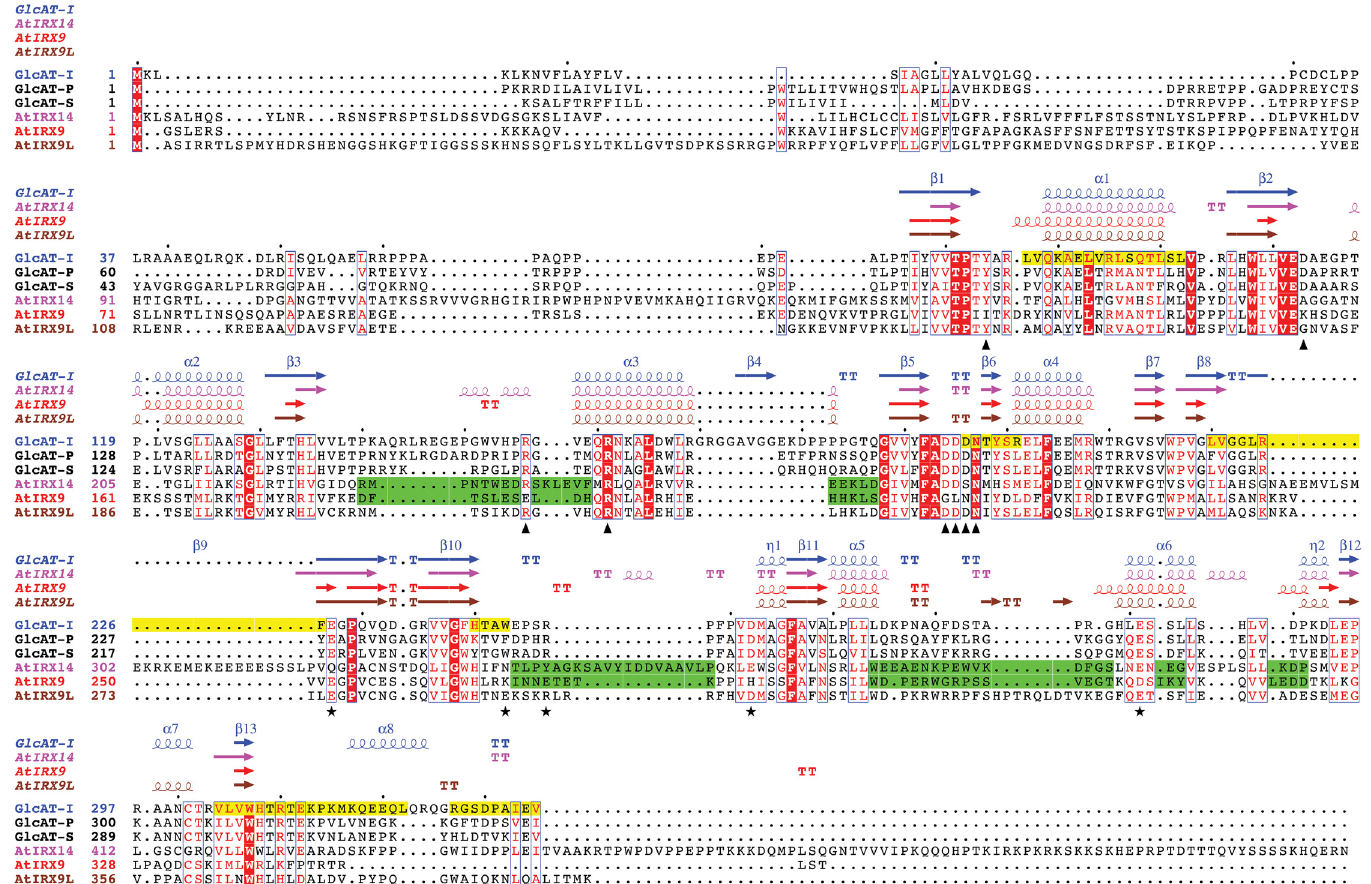
Fig 1. Sequence alignment of human and Arabidopsis GT43 proteins. Human proteins GlcAT-I (UniProt ID: O94766), GlcAT-P (Q9P2W7), GlcAT-S (Q9NPZ5) and Arabidopsis proteins AtIRX9, AtIRX9L and AtIRX14 were used to build the alignment using MAFFT program [41]. The alignment graph was generated using ESPript server [45], which also took the PDB format files of GlcAT-I (PDB ID: 1kws), AtIRX9 (predicted), AtIRX9L (predicted) and AtIRX14 (predicted) to display their secondary structures. Arrows and stars below the alignment indicate residues in GlcAT-I structure that interact with UDP-GlcA (sugar donor) and the trisaccharide Gal β 1-3Gal β 1-4Xyl (sugar acceptor). Yellow shaded regions indicate protein-protein interaction (PPI) regions reported in GlcAT-I structure [21]. Green shaded regions indicate weakly aligned regions that do not overlap with PPI regions.